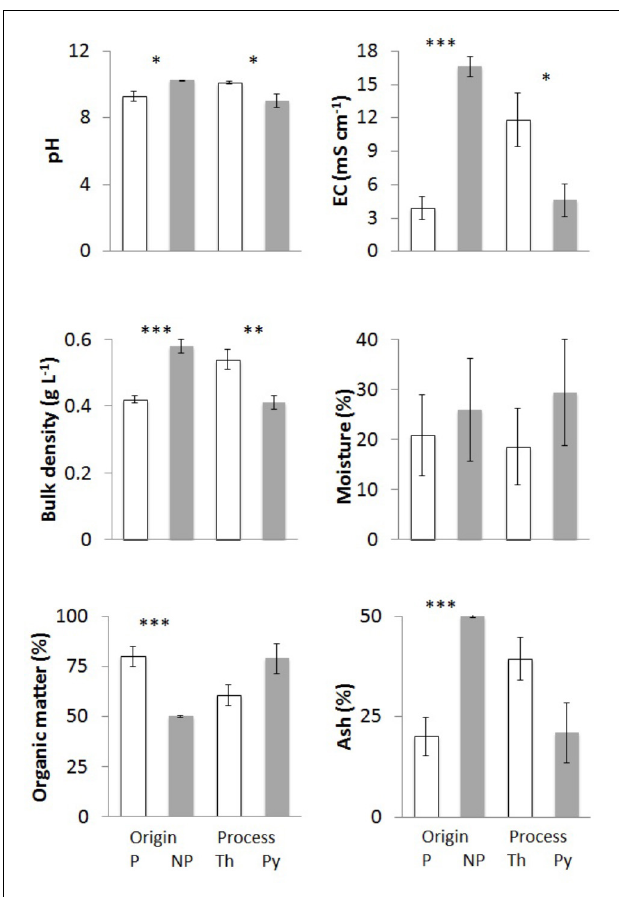
FIGURE 1 | Physicochemical parameters of chars from different feedstock and production process: pH, electrical conductivity, bulk density, moisture, organic matter, and ash content. Bars “P” indicate chars of plant origin (A3, A4, E1 – white) and bars “NP” chars of non-plant origin (A1, A2 – gray). Bars “Th” indicate chars from (thermo)reforming (A1, A2, A3 – white), and “Py” chars from pyrolysis (A4, E1 – gray). Means of at least three biological replicates per char are reported, with standard error of the mean. Asterisks show the significance of pairwise comparisons (one-way ANOVA) between chars derived from different feedstocks (P/NP) or from different processes (Th/Py): ∗ p < 0.05; ∗∗ p < 0.01; ∗∗∗ p < 0.001.